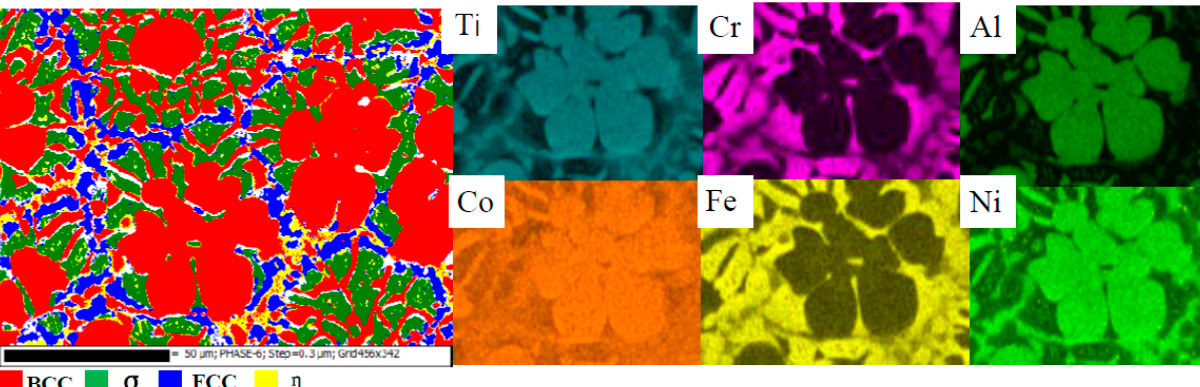
Figure 2. EBSD results of Ti-0.8 HEA.